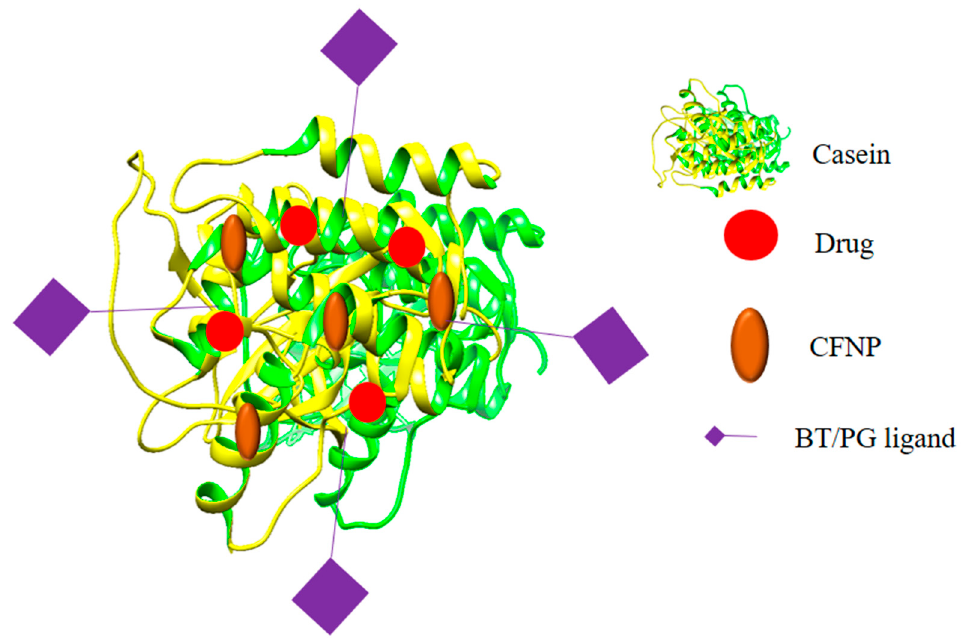
Figure 6 .A generalized structure of casein ‐ based nanohybrids. Figure 6. A generalized structure of casein-based